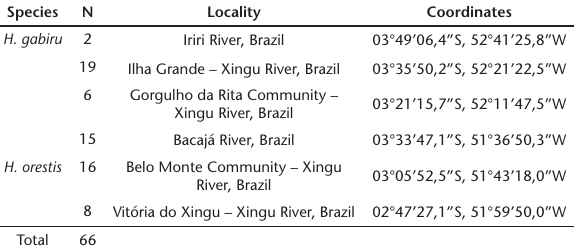
Table 2. Host species, number of host specimens collected, localities and respective geographical